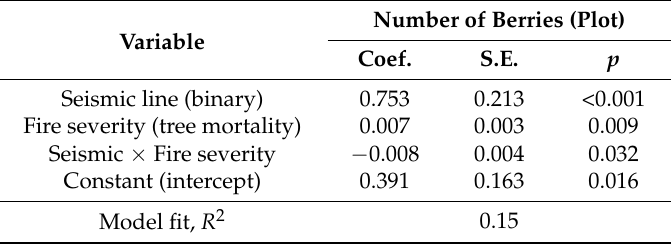
Table 2. Mixed effect linear regression model testing differences in Vaccinium myrtilloides berry production in response to location (seismic line versus adjacent forest), fire severity, and the interaction of fire severity and location. Note that results are based on a log 10 transformed count of